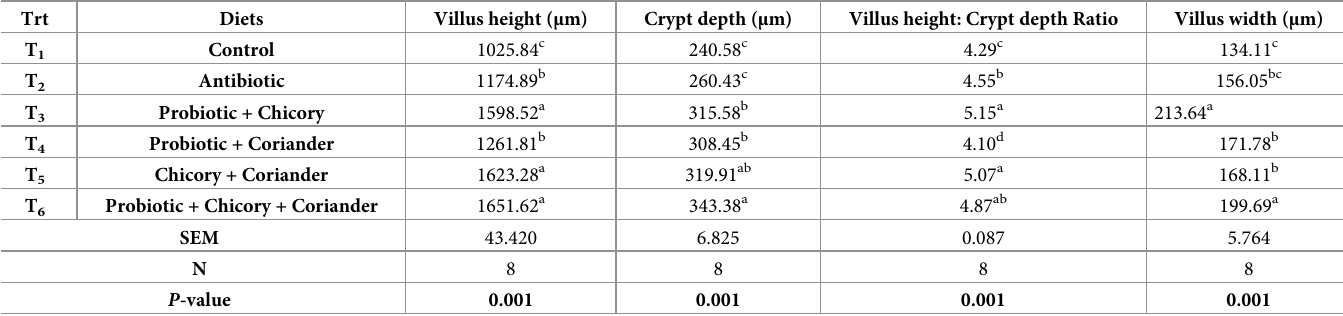
Values bearing different superscripts within a column are significantly (P < 0.05) different